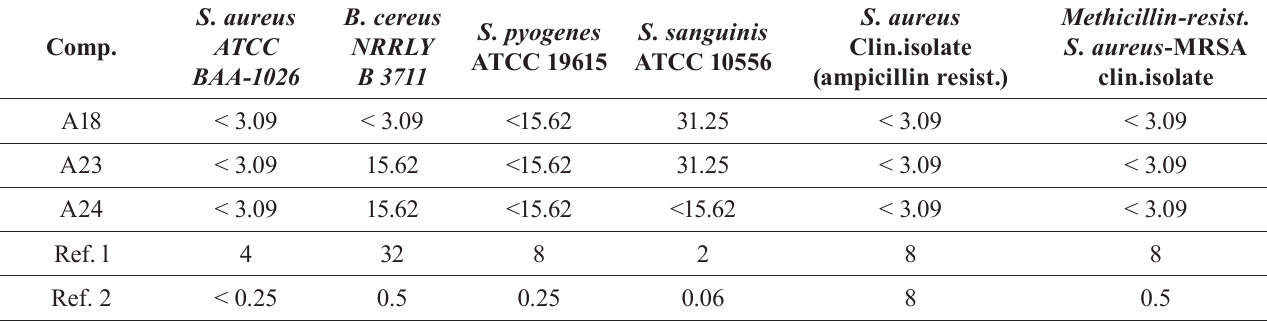
TABLE III – Antimicrobial (MIC µg/mL) effect of compound V(A2,A3,A8,A9,A10,A15,A16,A17,A18,A23 and A24)